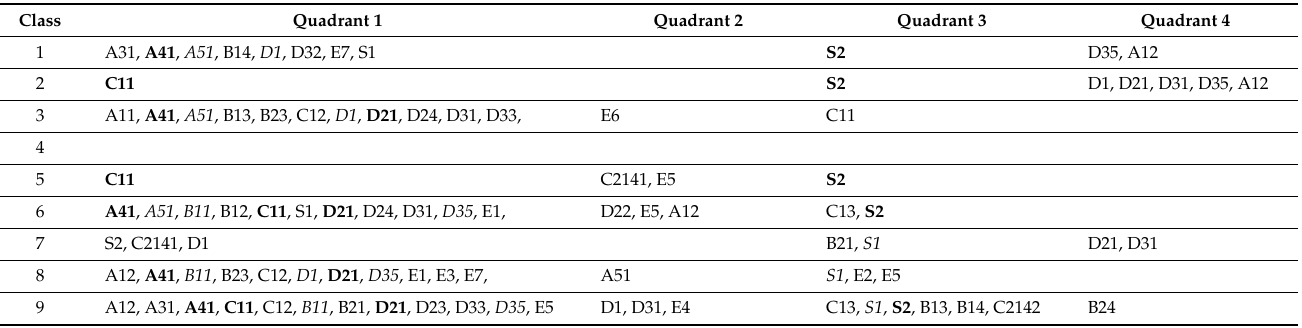
Table 9. Multiple cases: associating personal behaviors to his/her own mood states (A21) as focal behavior with category selection as conditioned behaviors.